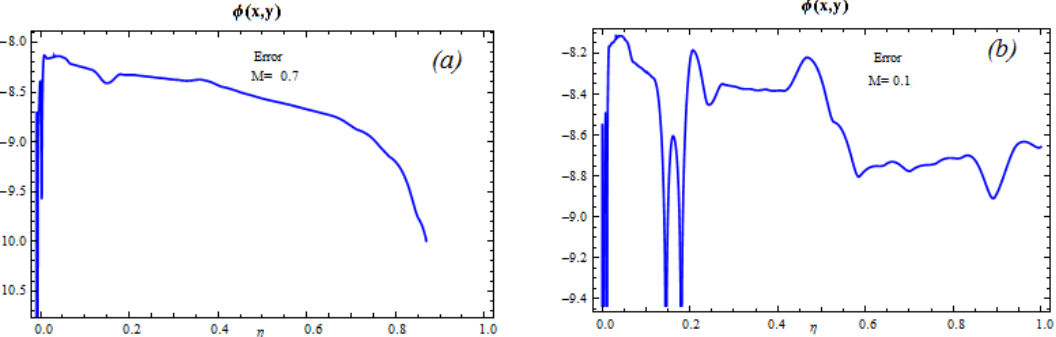
Figure 4. Temperature error analysis for physical parameters ( a ) α = 2 and ( b ) α = 1.